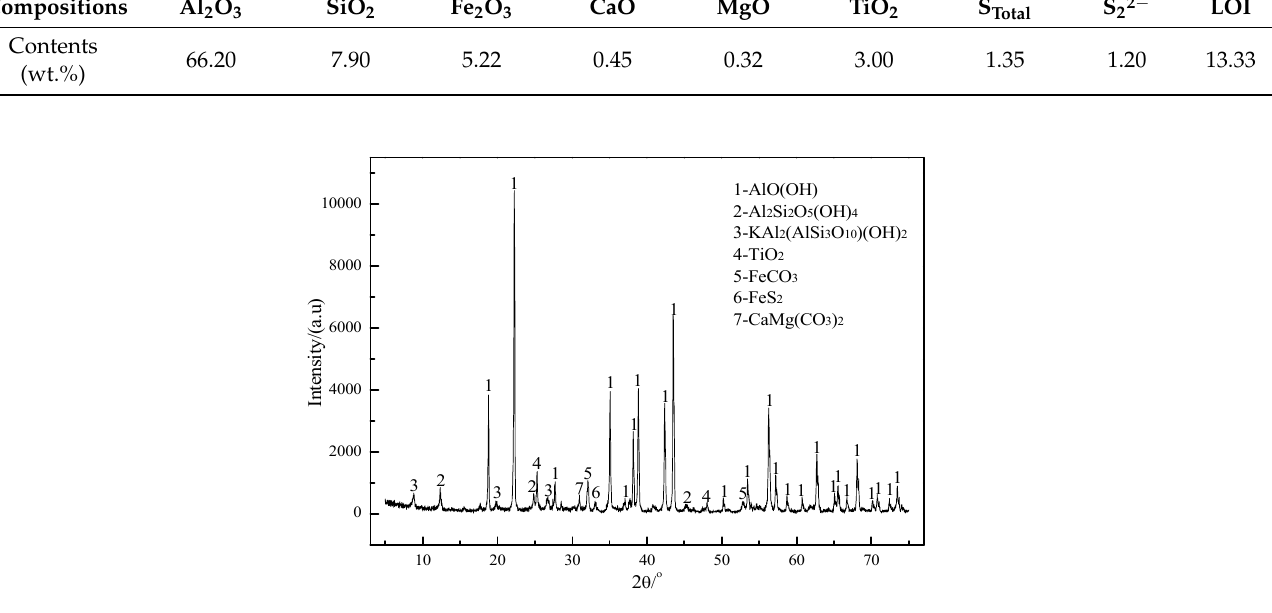
Table 1. Chemical composition and loss on ignition of high-sulfur bauxite. Table 2. Mineral composition of hi gh ‐ sulfur bauxite.